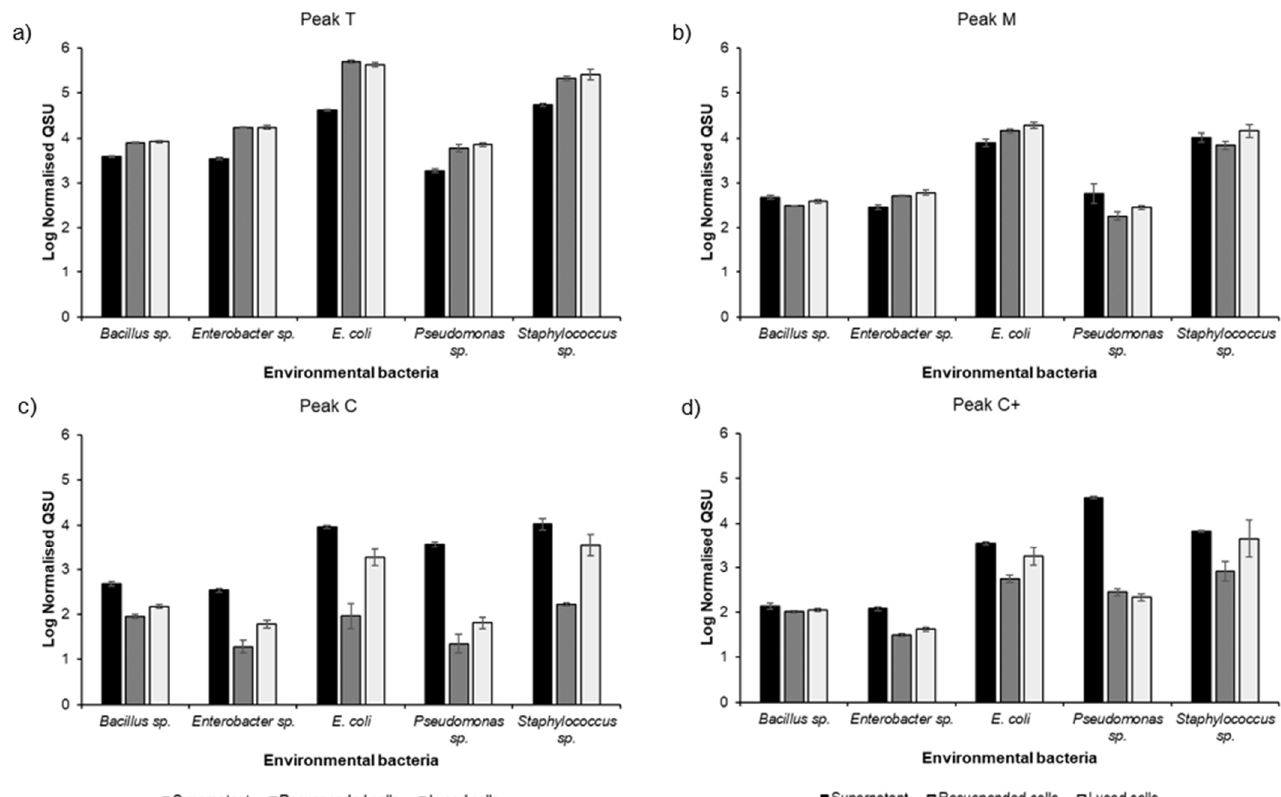
Figure 3. Apportionment of observed fluorescent organic matter peaks T, C, C+ and M in sample fractions of five environmental bacterial isolates, cultured for 24 h at 30 ◦ C. Fluorescence intensities are reported in Log Normalised QSU, whereby cell density normalised QSU is expressed as fluorescence intensity per 10 10 cfu mL − 1 . ( a ) Peak T, λ ex/ λ em 280/330–360 nm; ( b ) Peak M, λ ex/ λ em 300 /380–420 nm; ( c ) Peak C, λ ex/ λ em 350/420–460 nm; ( d ) Peak C+, λ ex/ λ em 400/440–480 nm ( n = 3 ±